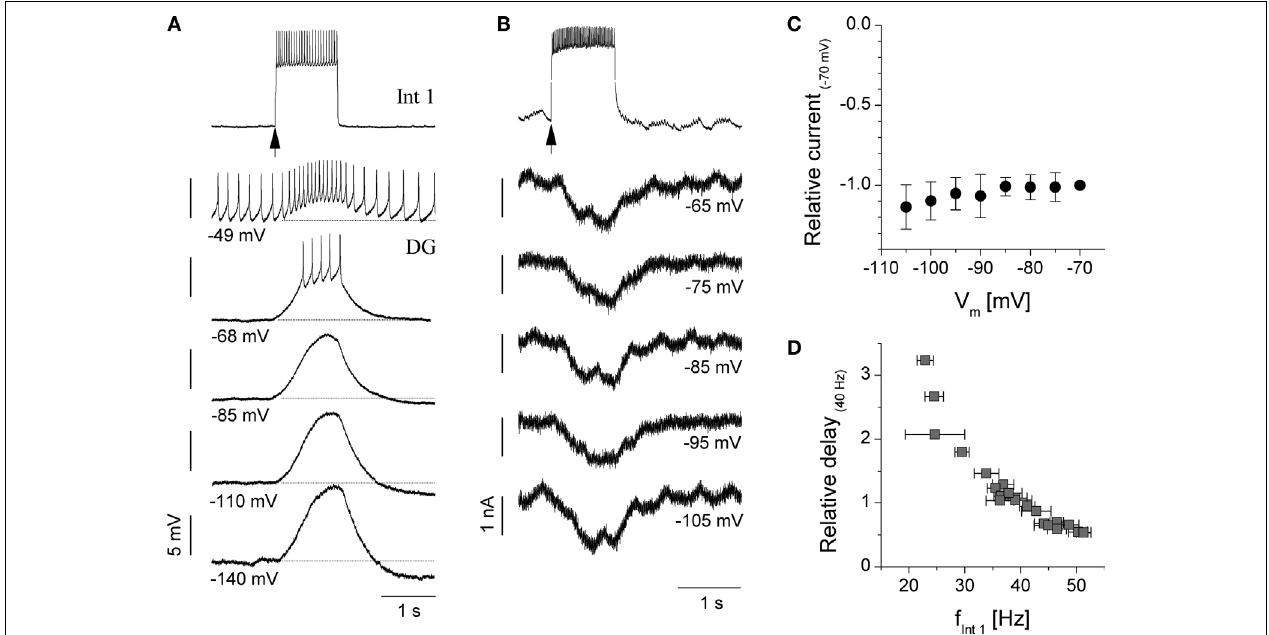
FIGURE 5 | Current and voltage clamp study of the slow excitatory coupling from Int 1 to the DG neuron. (A) Delayed excitation of DG following depolarizing pulse to Int 1 recorded in current clamp. Note the almost constant size of the responses at various levels of DG membrane potential, i.e. lack of reversal in a 90 mV range. Here, anterior inputs were blocked using the sucrose knife technique. (B) Transmembrane current of the DG neuron in voltage clamp. Int 1 induced depolarization of the DG manifests as an inward current. 2 Hz oscillation of the membrane current appears as a result of the input from the P cell (pyloric